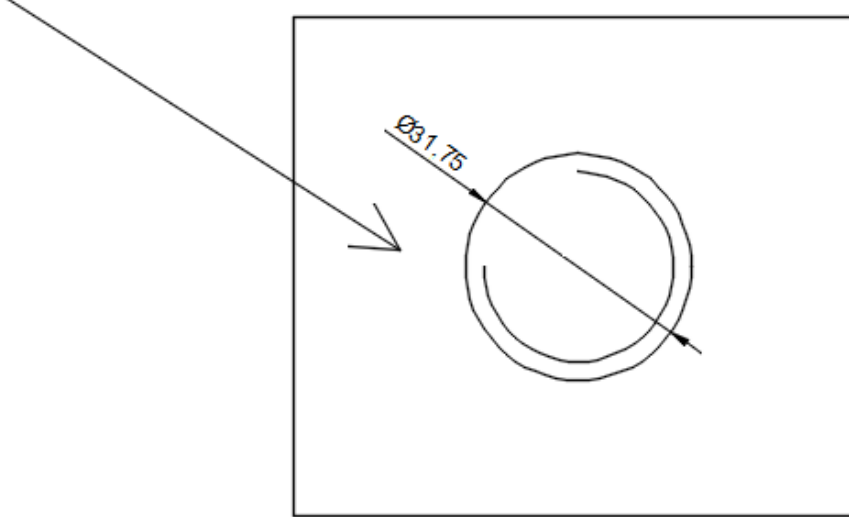
Figure 1. The dimensions of the used heat sink (in mm).